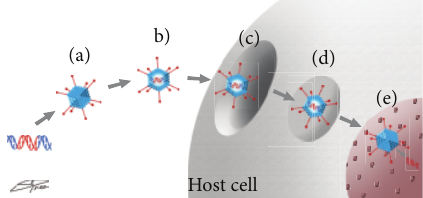
Figure 1: Schematic diagram of gene therapy with AAV. (a) Genetic material is biochemically engineered into the DNA of an AAV vector. (b) AAV is injected into the host. (c) Vesicle formation. (d) Internalization of AAV. (e) Breakdown of vesicle and delivery of genetic material to cell nucleus for protein